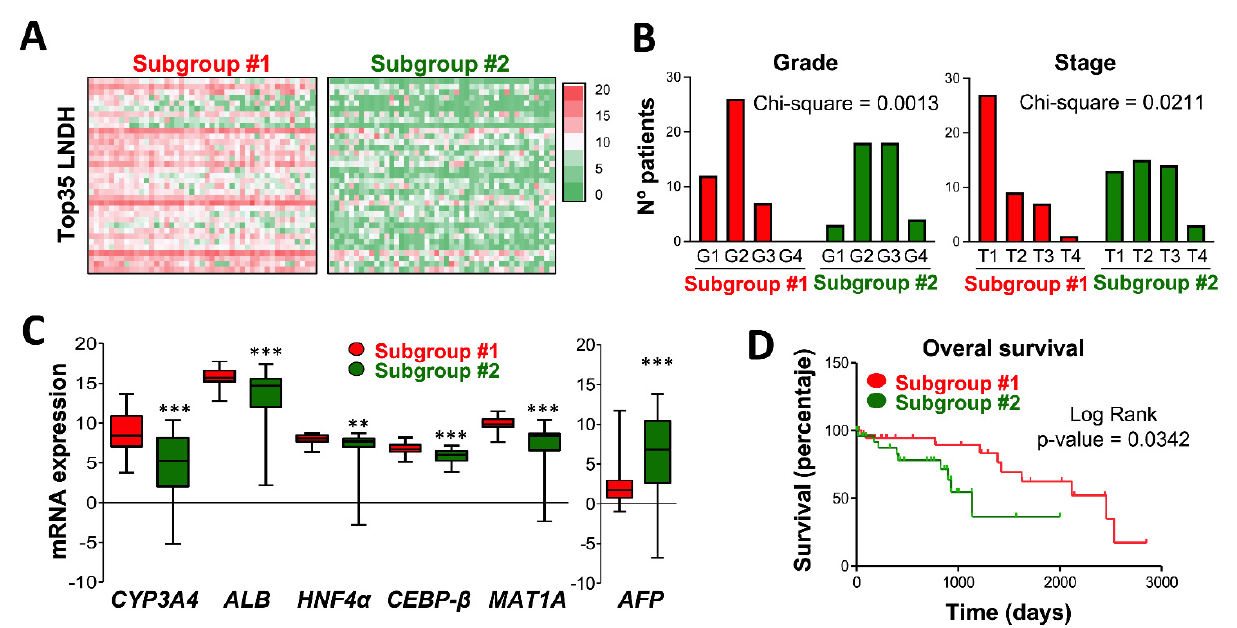
Figure 6. The Top35 LNDH correlates with tumor differentiation and patient survival. ( A ) Heatmap reporting the expression levels of each lncRNA from the Top35 LNDH in the two HCC subgroups established from the LIHC TCGA cohort: Subgroup #1 (45 patients) with higher level of expression of Top35 LNDH and Subgroup #2 (45 patients) with lower level of expression of Top35 LNDH. The color scale bar is shown on the right representing relative expression. ( B ) Number of patients at the different histological grade (G1 to G4) and pathological stage (T1 to T4) in each subgroup defined as in A. ( C ) Box plots reporting the mRNA expression levels of CYP3A4 , ALB , HNF4 α , C/EBP- β , MAT1A and AFP obtained from the LIHC TCGA cohort in the two HCC subgroups established as described in A (Subgroup #1 in red and Subgroup #2 in green). The U the Mann-Whitney test was used for statistical analysis. ( D ) Kaplan-Meier curves reporting the overall survival of the two HCC subgroups established as described in A. ** p < 0.01, *** p < 0.001.